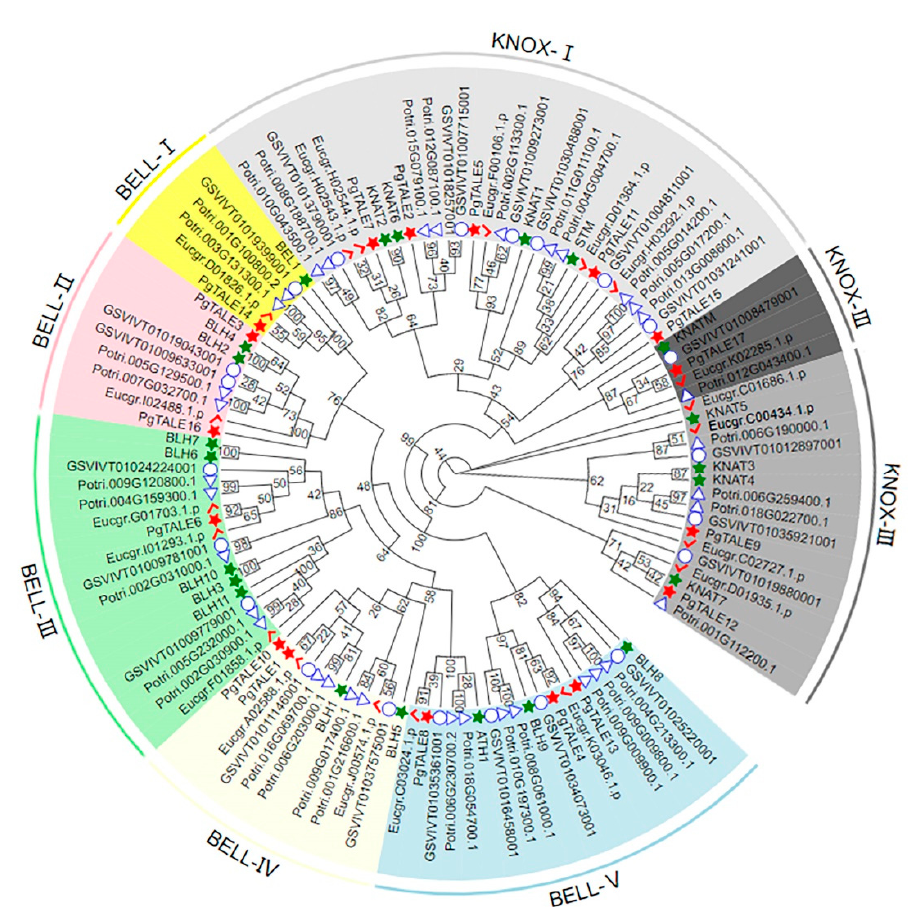
Figure 1. The phylogenetic tree of the three-amino-acid-loop-extension (TALE) gene family in pomegranate, A. thaliana , E. grandis, P. trichocarpa and V. vinifera. The phylogenetic tree was constructed by RA × ML -NG with Bootstrap 1000 repeats and the best model of JTT + F + I + G4. Pomegranate, A. thaliana , E. grandis, P. trichocarpa and V. vinifera TALE proteins are marked with a solid red star, solid green star, red check, blue triangle and blue circle, respectively.